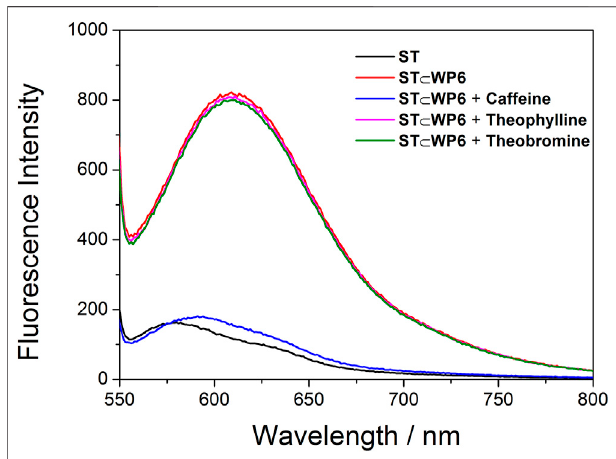
FIGURE 4 | Fluorescence spectra for ST (0.02 mM) + WP6 (0.35 mM) with caffeine (2 mM), theophylline (2 mM), and theobromine (2 mM), respectively.